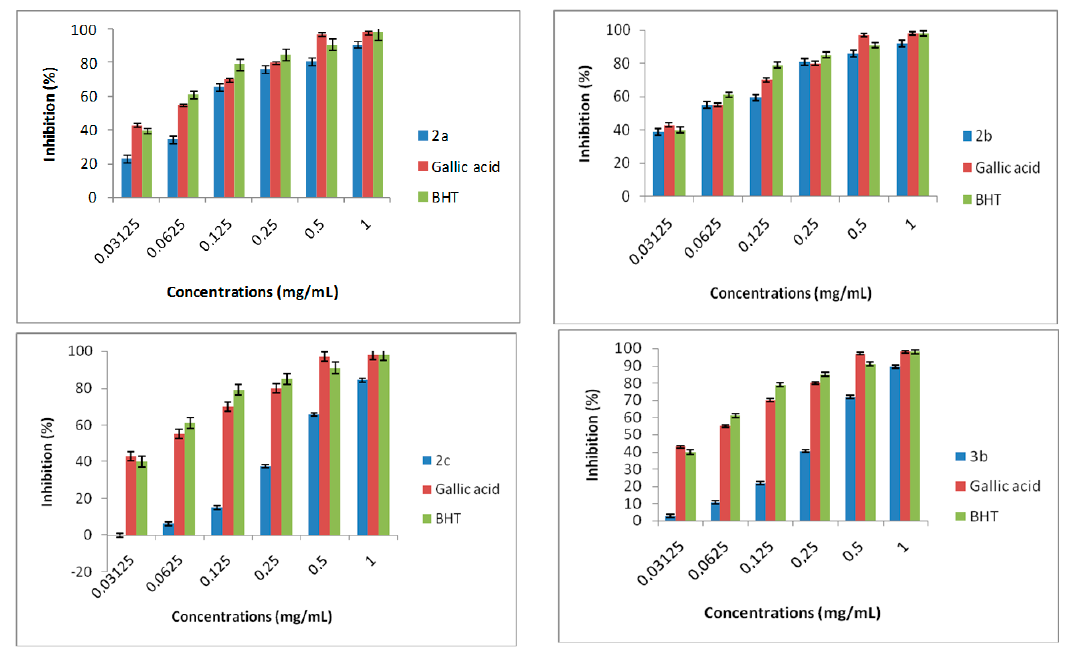
Figure 7. Scavenging activity of compounds 2a – c and 3b on DPPH radicals.